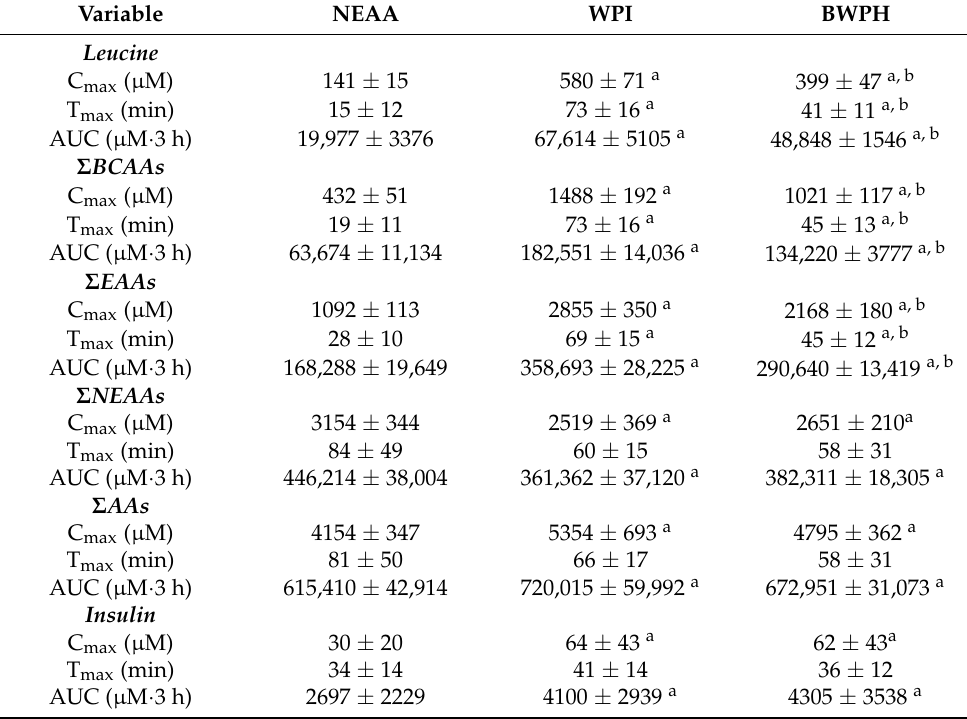
Table 2. Peak concentration, time to peak concentration, and area under the curve for serum amino acids and insulin following each experimental condition in healthy older adults ( n = 7). Data presented as mean ±